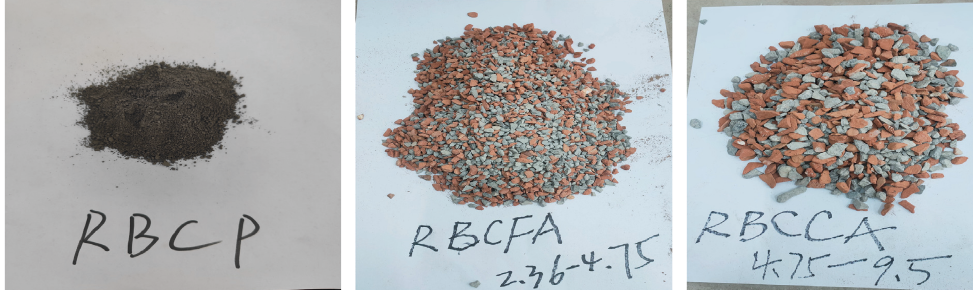
Figure 2: Recycled products with RBCP, RBCFA, and RBCCA.